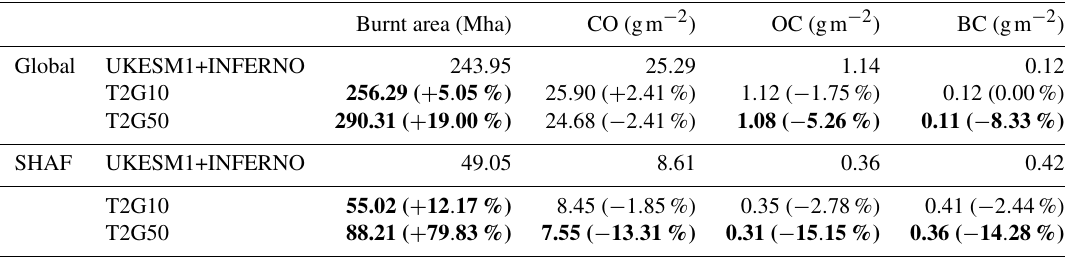
Table 2. Total annual average values and relative change (%) compared to UKESM1+INFERNO (period between 1980–1985) of burnt area (Mha), carbon monoxide (gm − 2 ), organic carbon (gm − 2 ) and for black carbon (gm − 2 ) for UKESM1+INFERNO and the different sensitivity experiments, T2G10 and T2G50 – global and SHAF regions. Values in bold show that the difference between a given experiment and UKESM1+INFERNO is statistically significant with a 95% confidence